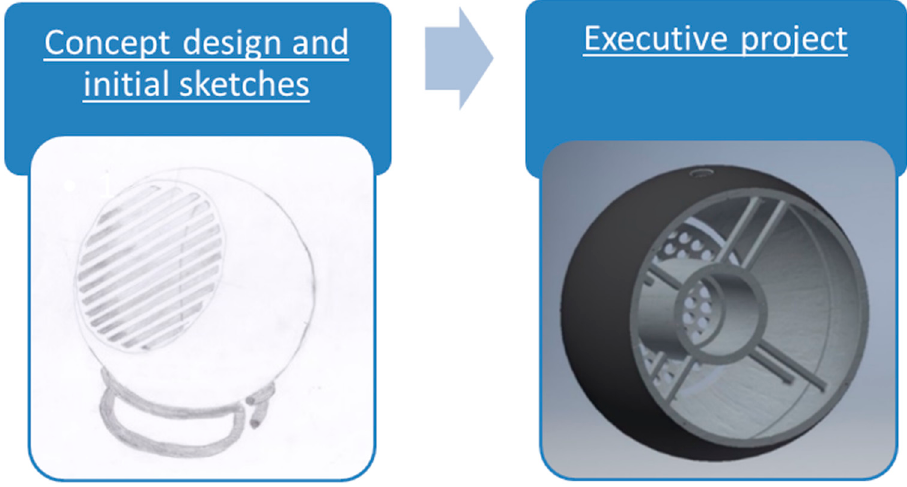
Figure 11. Concept design and initial sketches to executive project.